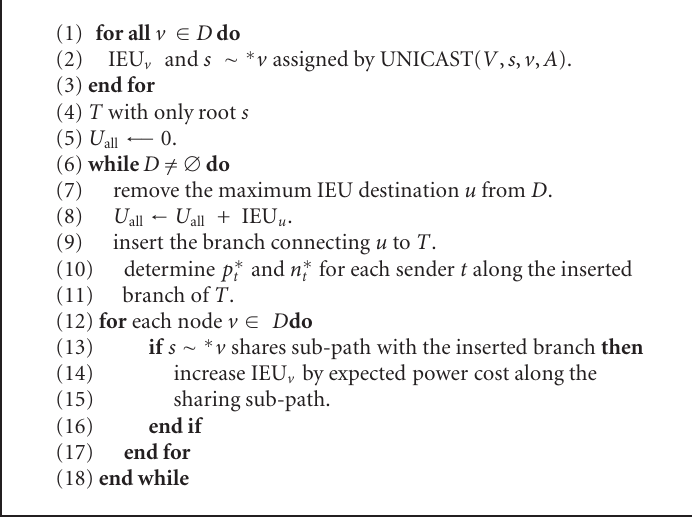
Algorithm 2: MIEUDF( V , D , s , A , T